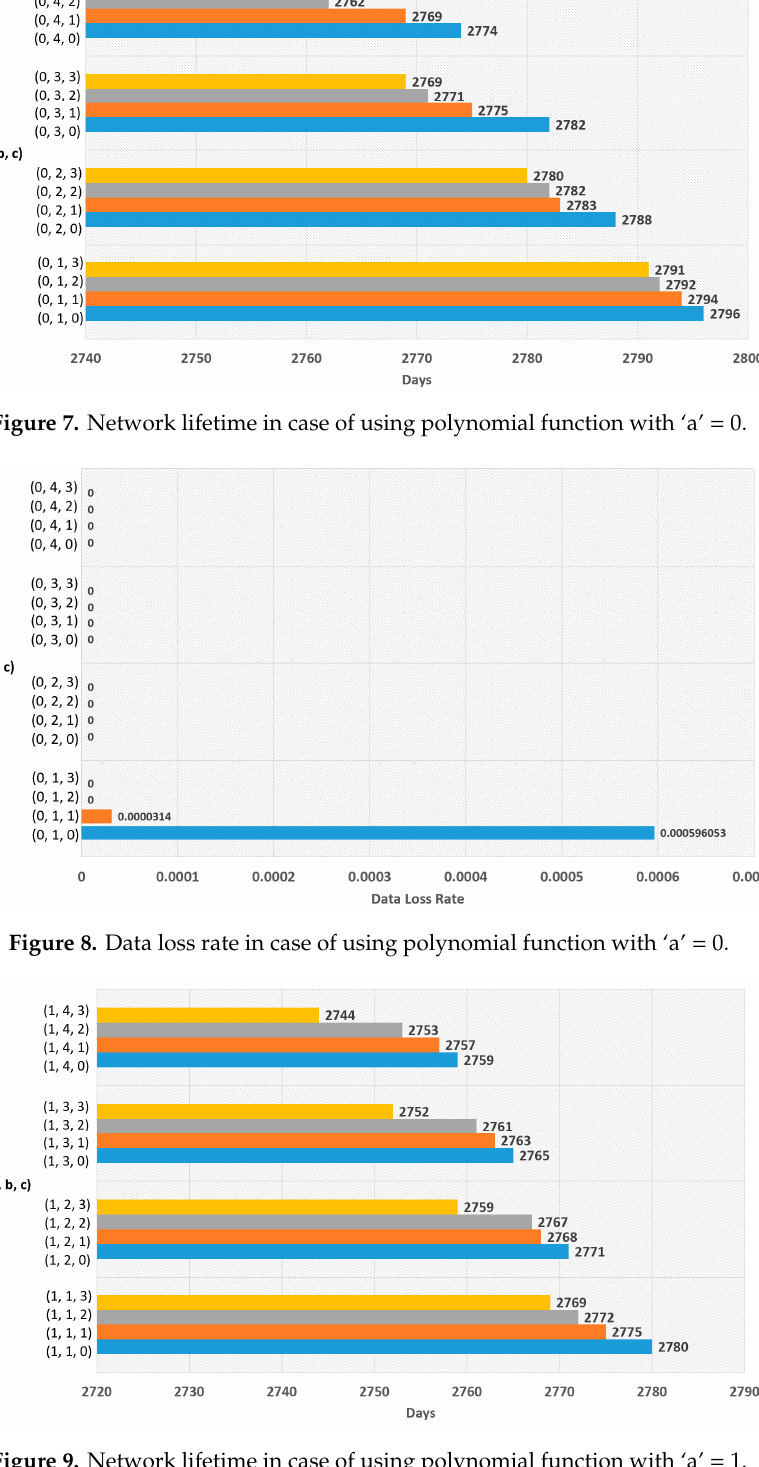
Figure 9. Network lifetime in case of using polynomial function with ‘a’ = 1.